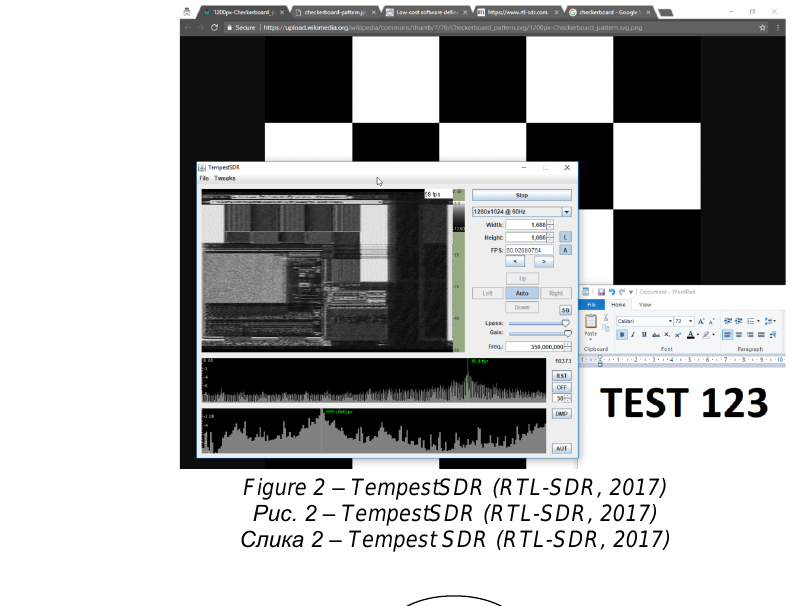
Figure 2 – TempestSDR (RTL-SDR, 2017) Рис. 2 – TempestSDR (RTL-SDR, 2017) Слика 2 – Tempest SDR (RTL-SDR,